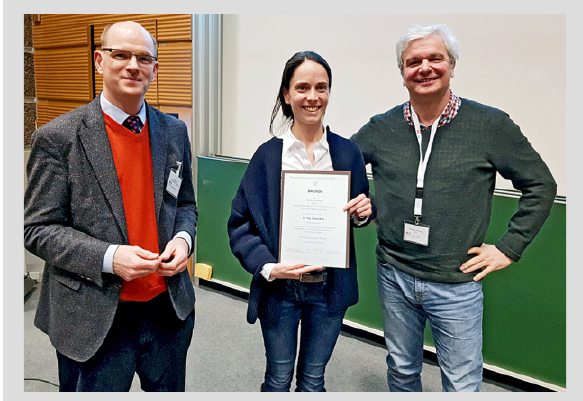
Figure 2: Susanna Formenti, KUL Leuven (Best Poster Award), and Steffen Recktenwald (Best Presentation